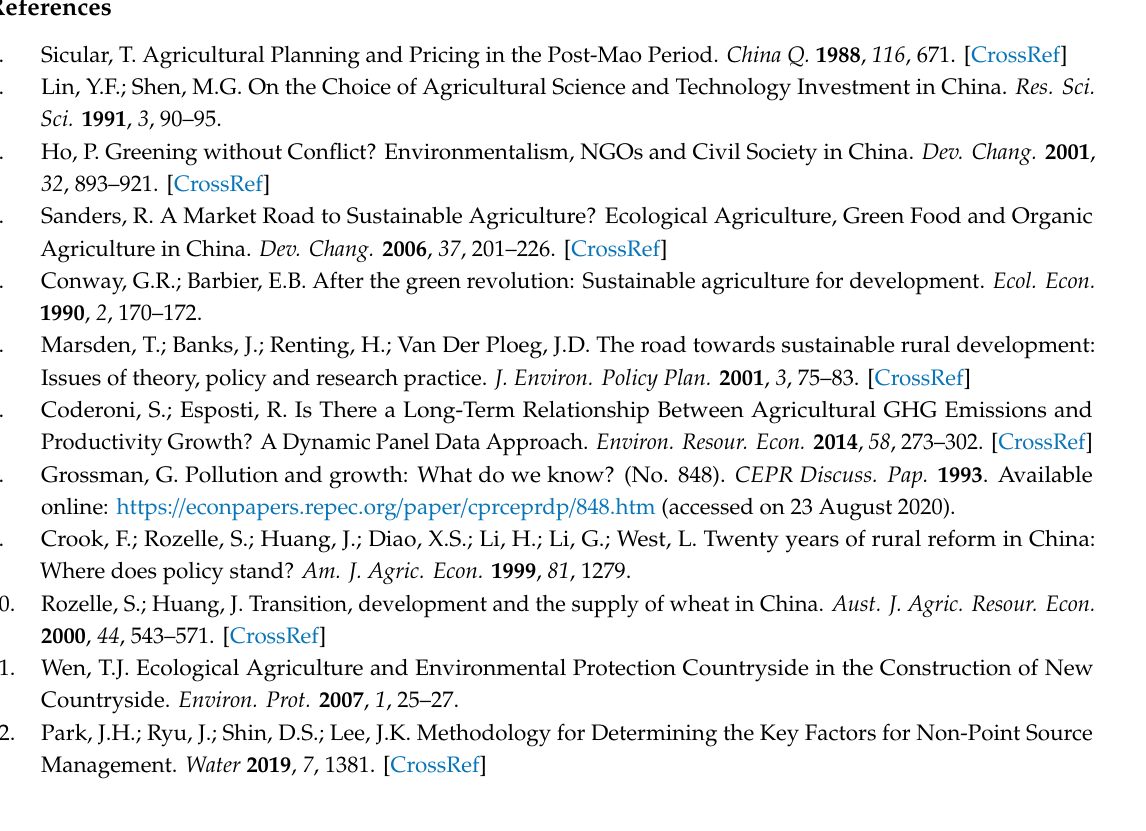
Table S1: The impact of financial development on agricultural NPS pollution in